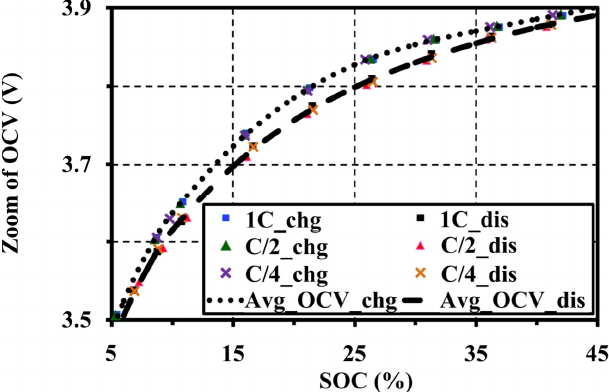
Figure 10. Zoom of the hysteresis occurrence tested at 20 °C with 60 min resting.